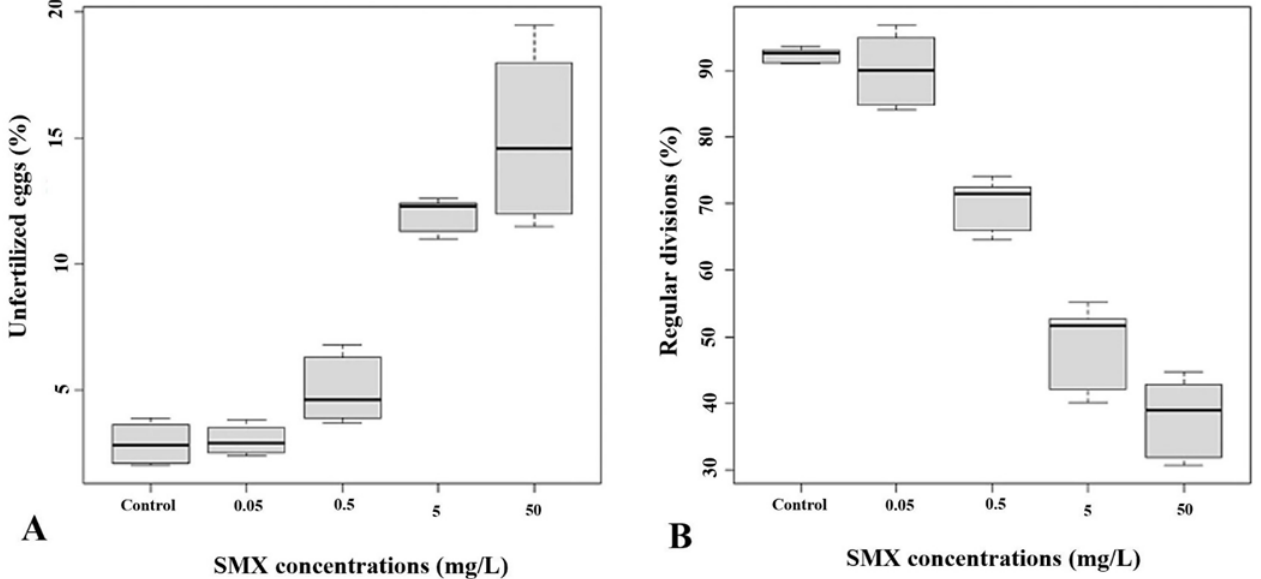
Figure 1. Percentage of unfertilized eggs ( A ) and regular divisions ( B ) considering division stages with a number of blastomeres ≥16 after the simultaneous exposure (SE) of the eggs and spermatozoa to the SMX solutions. Black bars represent medians.